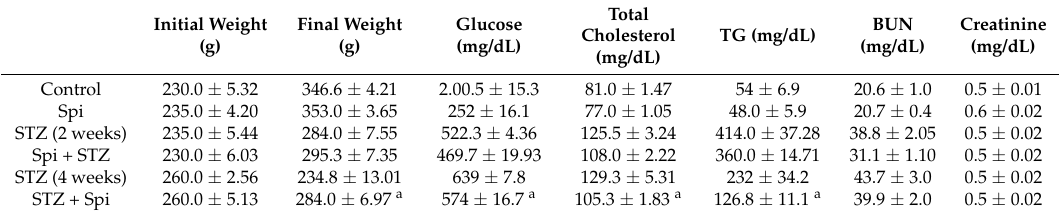
Table 3. Effects of streptozotocin (STZ) and Spirulina (Spi) extract on body weight; levels blood glucose, cholesterol, TG, BUN,